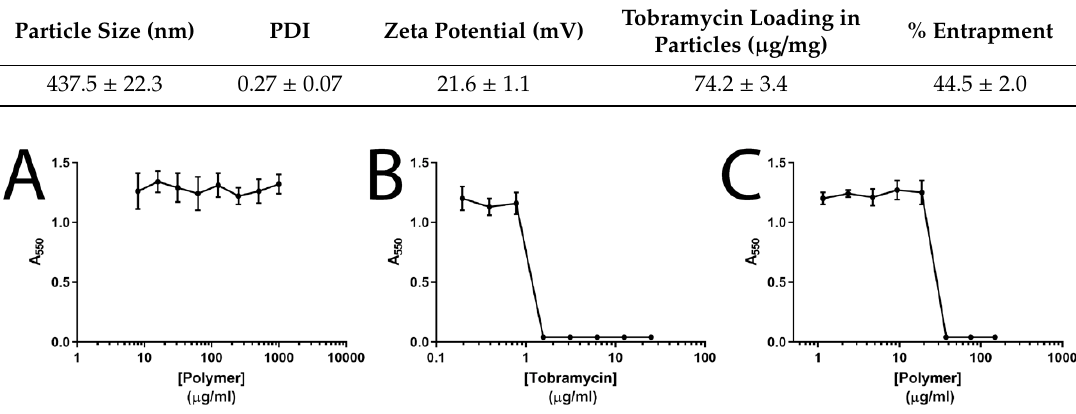
Figure 2. Minimum inhibitory concentration (MIC) analysis of tobramycin-loaded alginate / chitosan particles against P. aeruginosa . ( A ) Unloaded particle control. ( B ) Free tobramycin. ( C ) Tobramycin loaded particles. Mean values ± S.D, N = 3.